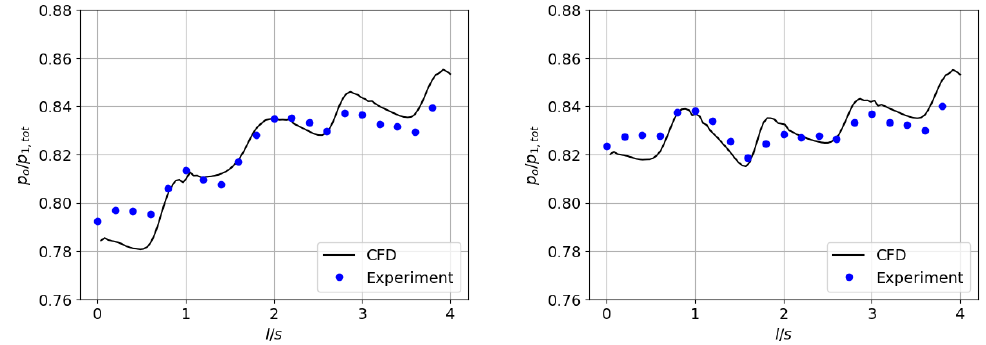
Figure 15. Pressure distribution along the outlet probe line ( left pane α = − 3°, right pane α = 3°). Table 1. Reference isentropic Mach number M o for outlet pressure corresponding to M 2, is = 0.5. α